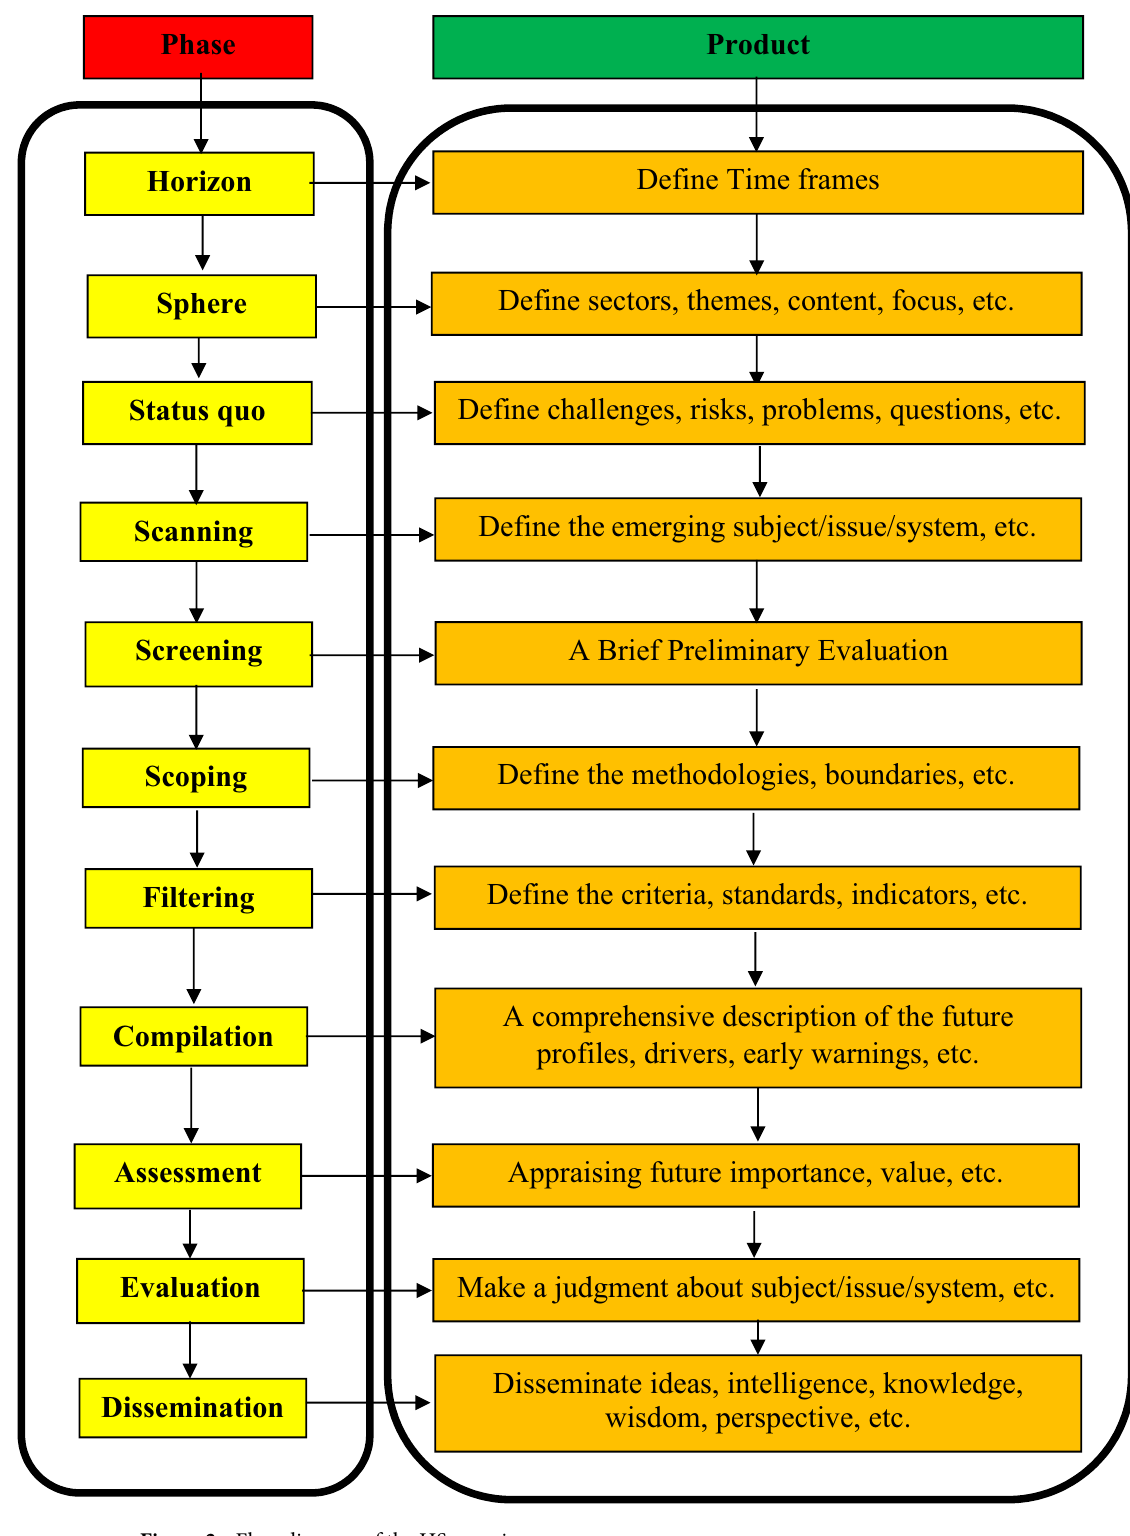
Figure 2. Flow diagram of the HS generic